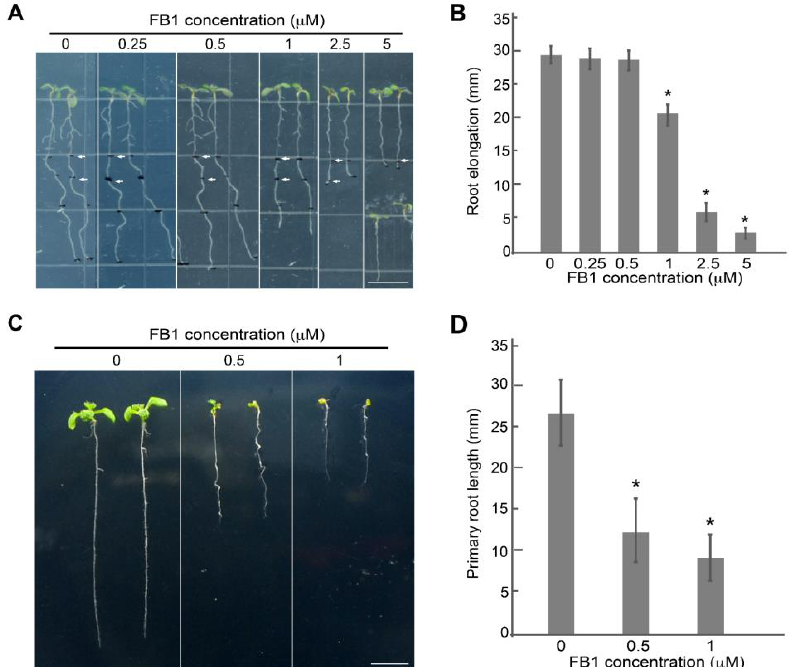
Figure 1. FB1 represses primary root growth. ( A ) Phenotypes of 4-DAG wild-type seedlings trans- ferred onto half-strength MS medium (0) or half-strength MS medium containing 0.25, 0.5, 1, 2.5, or 5 μ M FB1 for 3 days. The white arrowhead indicates the growth length of seedlings after transfer to FB1 medium for one day. Scale bar, 1 cm. ( B ) Primary root growth of wild-type seedlings after transfer to FB1 for 3 days in ( A ). Data are means ± standard deviation (SD) ( n = 15–20). ( C ) Representative images of Arabidopsis seedlings grown in the presence of various concentrations (0, 0.5, or 1 μ M) of FB1 for 7 days. Scale bar, 1 cm. ( D ) Primary root length of wild-type seedlings grown in FB1 for 7 days in ( C ). Data are means ± SD ( n = 15 – 20). Asterisk (*) denotes significant difference relative to the seedlings without FB1, as determined by t -test; p < 0.01.